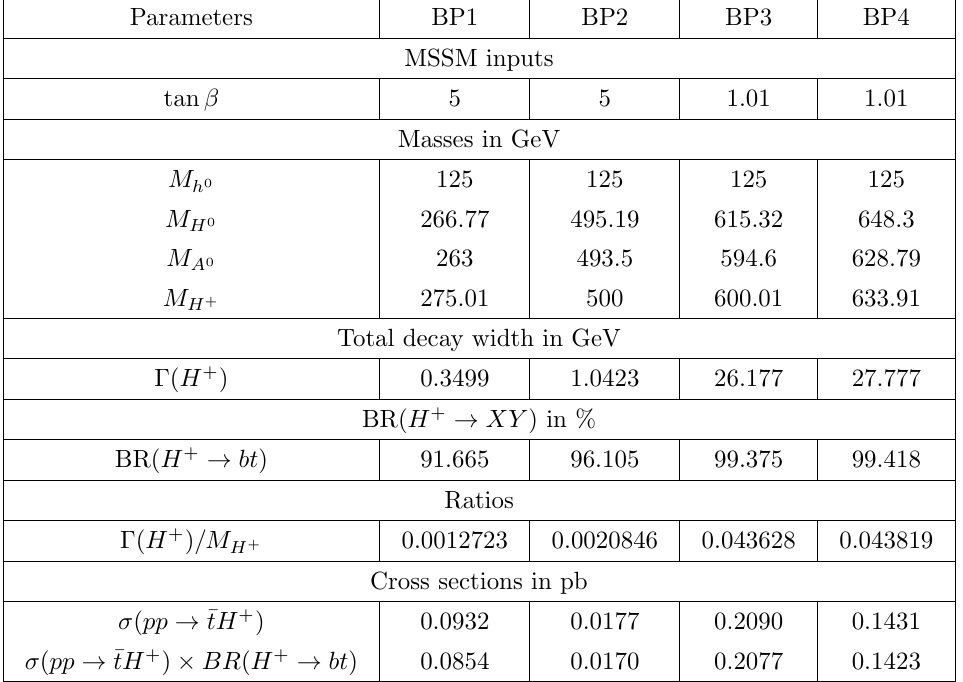
Table 3 . BPs for the h MSSM scenario.